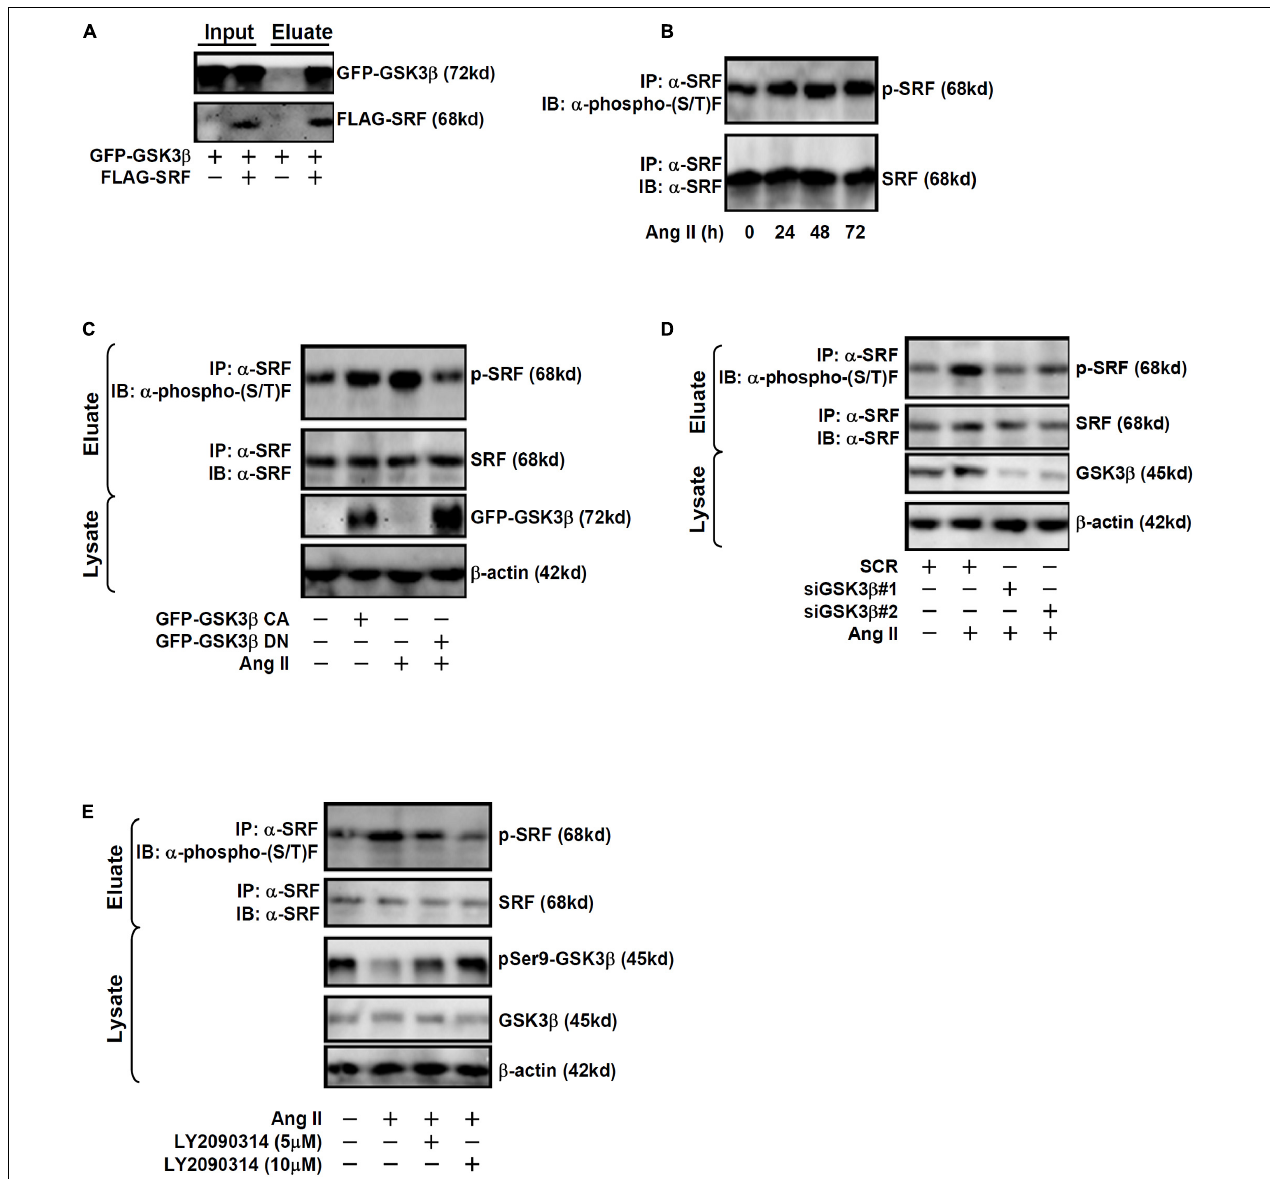
FIGURE 3 | GSK3 interacts with and phosphorylates SRF in endothelial cells. (A) EAhy926 cells were transduced with FLAG-tagged SRF and GFP-tagged GSK3 β followed by treatment with Ang II (0.1 µ M). Immunoprecipitation was performed with anti-FLAG. (B) EAhy926 cells were treated with Ang II (0.1 µ M) and harvested at indicated time points. Immunoprecipitation was performed with anti-SRF. (C) EAhy926 cells were transduced with adenovirus carrying GFP-tagged GSK3 β CA or GSK3 β DN followed by treatment with Ang II (0.1 µ M). Immunoprecipitation was performed with anti-SRF. (D) EAhy926 cells were transfected with siRNAs targeting GSK3 β or scrambled siRNA (SCR) followed by treatment with Ang II (0.1 µ M) for 48 h. Immunoprecipitation was performed with anti-SRF. (E) EAhy926 cells were treated with Ang II (0.1 µ M) with or without LY2090314 for 48 h. Immunoprecipitation was performed with